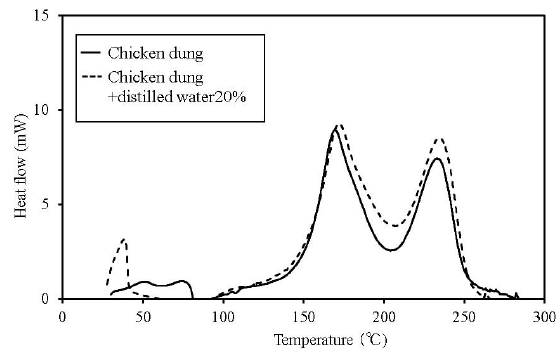
Figure 6. C80 calorimetry curves for sludge fuel.